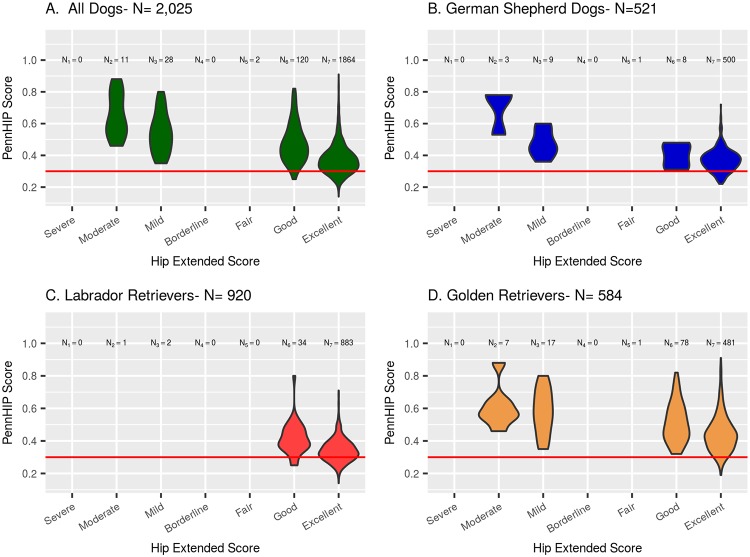
Distributions of DI values as a function of HESC class among dogs born into the latter generation classes.GSD’s born into generation 9 and later are in Panel B; LR’s born into generation 8 and later are in Panel C; and Golden Retrievers born into generation 7 and later are in Panel D.